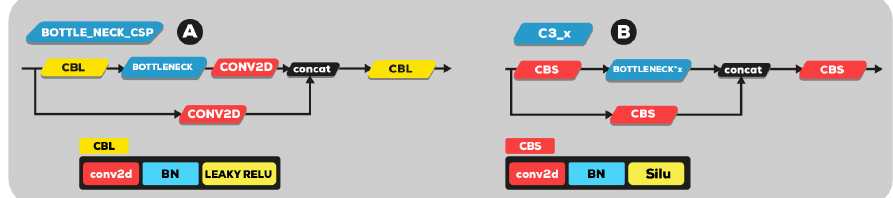
Figure 7. ( A ) YOLOv5 version 5.0 bottleneck CSP and ( B ) new C3